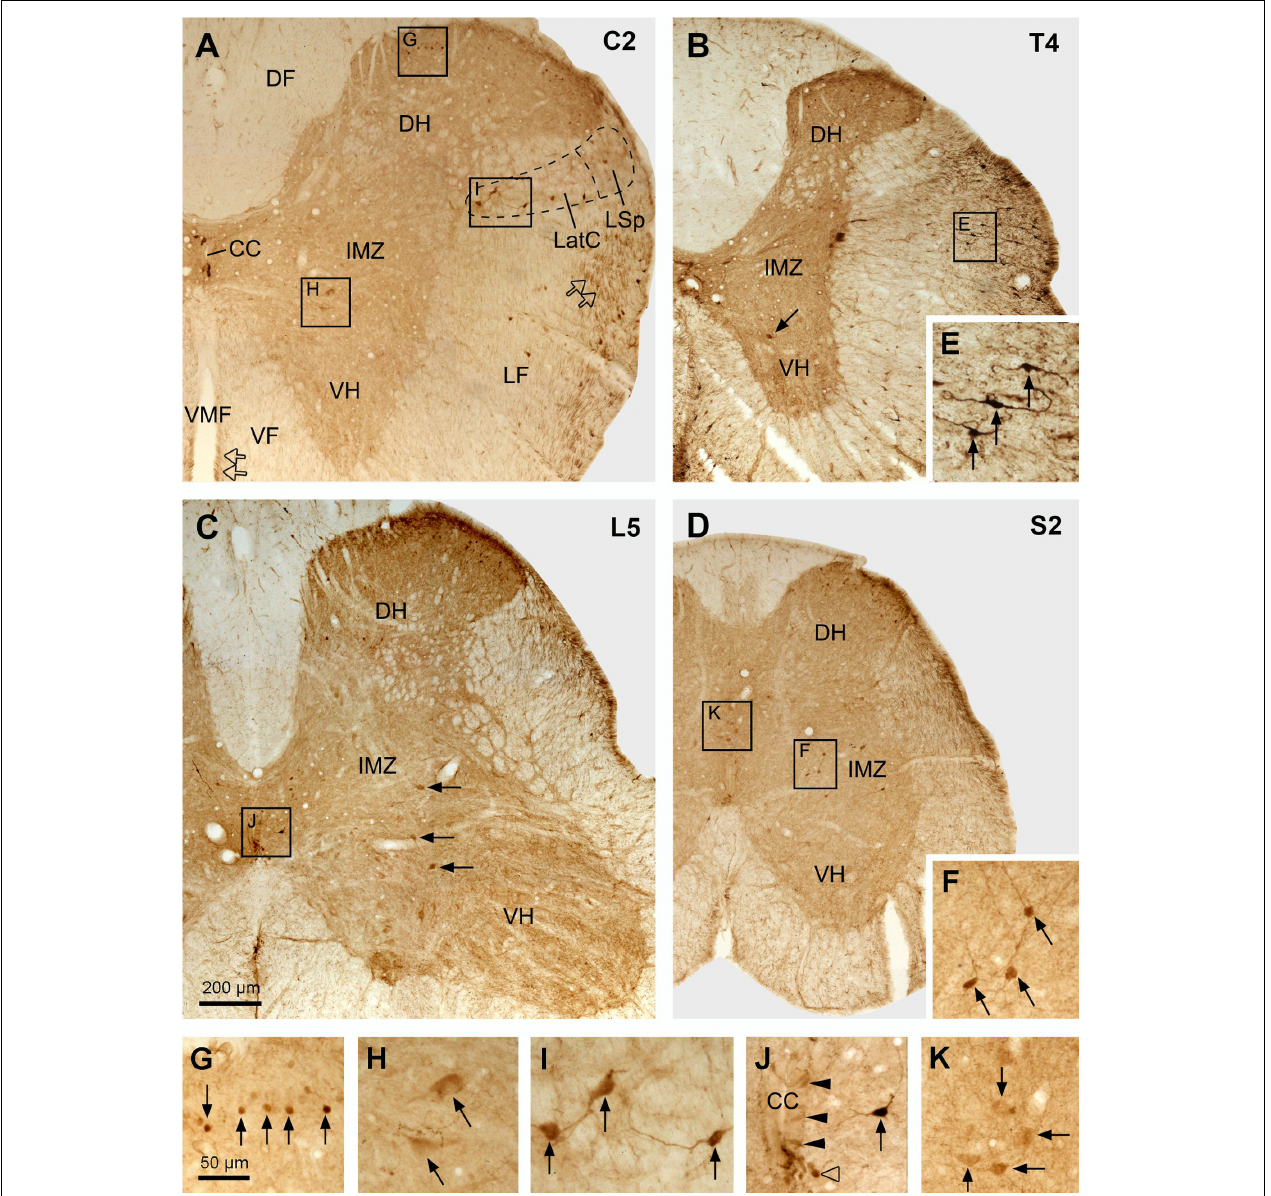
FIGURE 6 | Aromatic L -amino acid decarboxylase cell distribution in different parts of the spinal cord illustrated in transverse sections. (A–D) Photomicrographs of low magnification from selected sections from cervical (C) (A) , thoracic (T) (B) , lumbar (L) (C) , and sacral (S) (D) segments. The spinal segment of the section is indicated in the upper right corner in each panel. Arrows in (B,C) indicate the larger neurons in the IMZ/VH in the T and L segment, respectively. Hollow arrows in (A) indicate AADC fibers in the lateral funiculus (LF) and ventral funiculus (VF) close to the ventral median fissure (VMF). CC, central canal; DF, dorsal funiculus; DH, dorsal horn; LatC, lateral cervical nucleus; LSp, lateral spinal nucleus. (E–K) Enlargements of the areas in (A–D) demarcated with the squares/rectangles showing the details of the AADC-labeled neurons (arrows or arrowheads) in the white matter (E) , superficial DH (G) , IMZ (larger cells in H and smaller cells in F ), LatC (I) , around the CC ( J , arrowheads indicate the AADC cells around the CC, arrow indicates a AADC cell slightly further away from the CC), and the deep DH ( K , here the cells were from the sacral dorsal commissural nucleus). AADC antibody was from rabbit. Scale bar in (C) , valid for (A–D) , 200 µ m; in (G) , valid for (E–K) , 50 µ m.